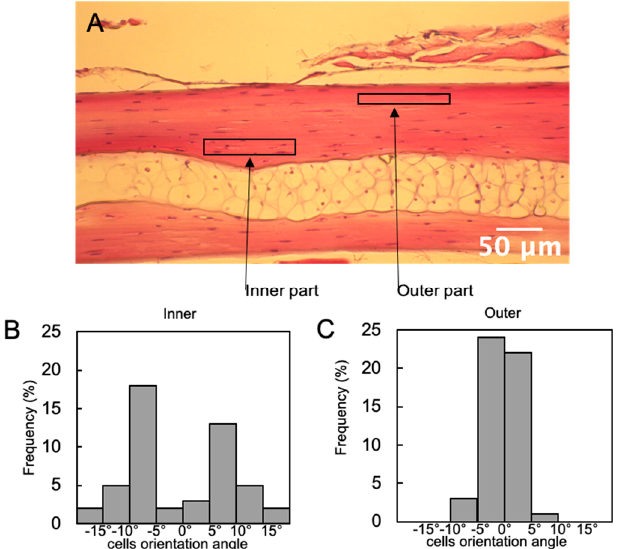
Figure 5. Cell alignment in Carassius langsdorfii rib bone. ( A ) Representative image of rib cross-section stained with HE. ( B , C ) In the cross-section of the fish rib, the outer osteocytes far from the lumen show better cell alignment than the inner osteocytes. The same result was observed in either